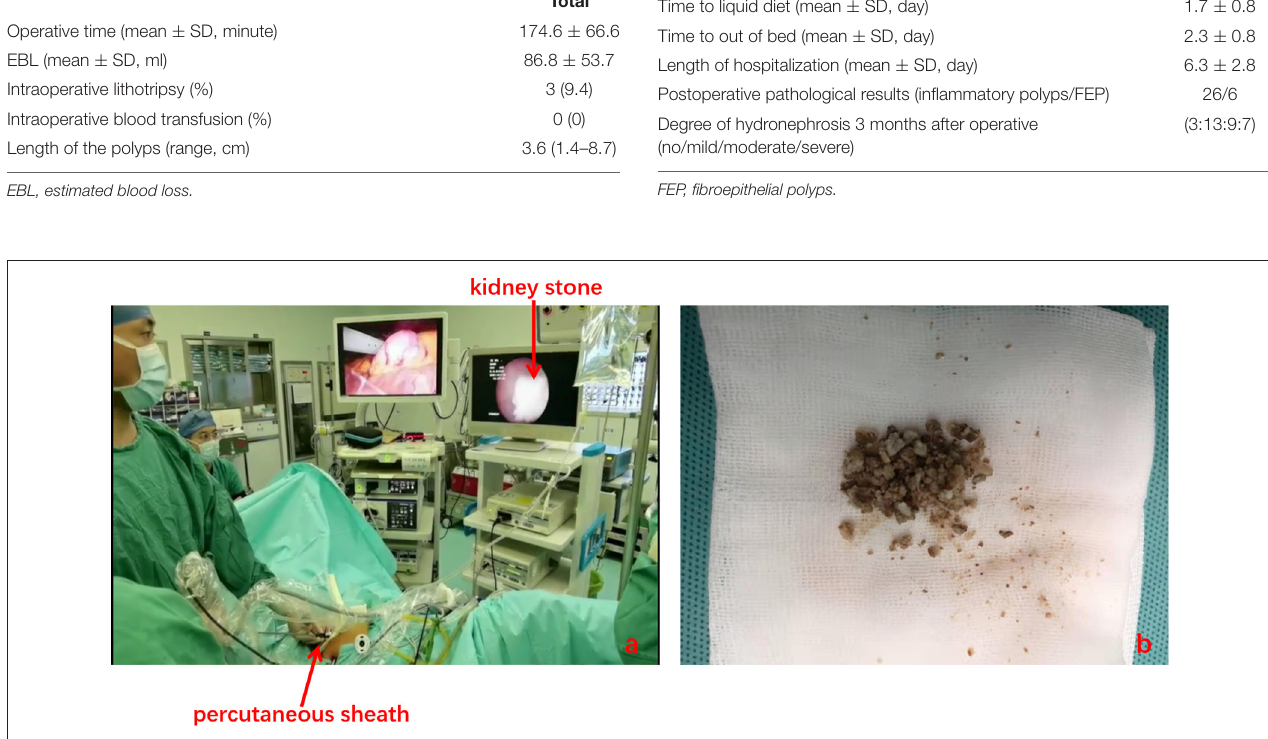
Frontiers in Surgery |